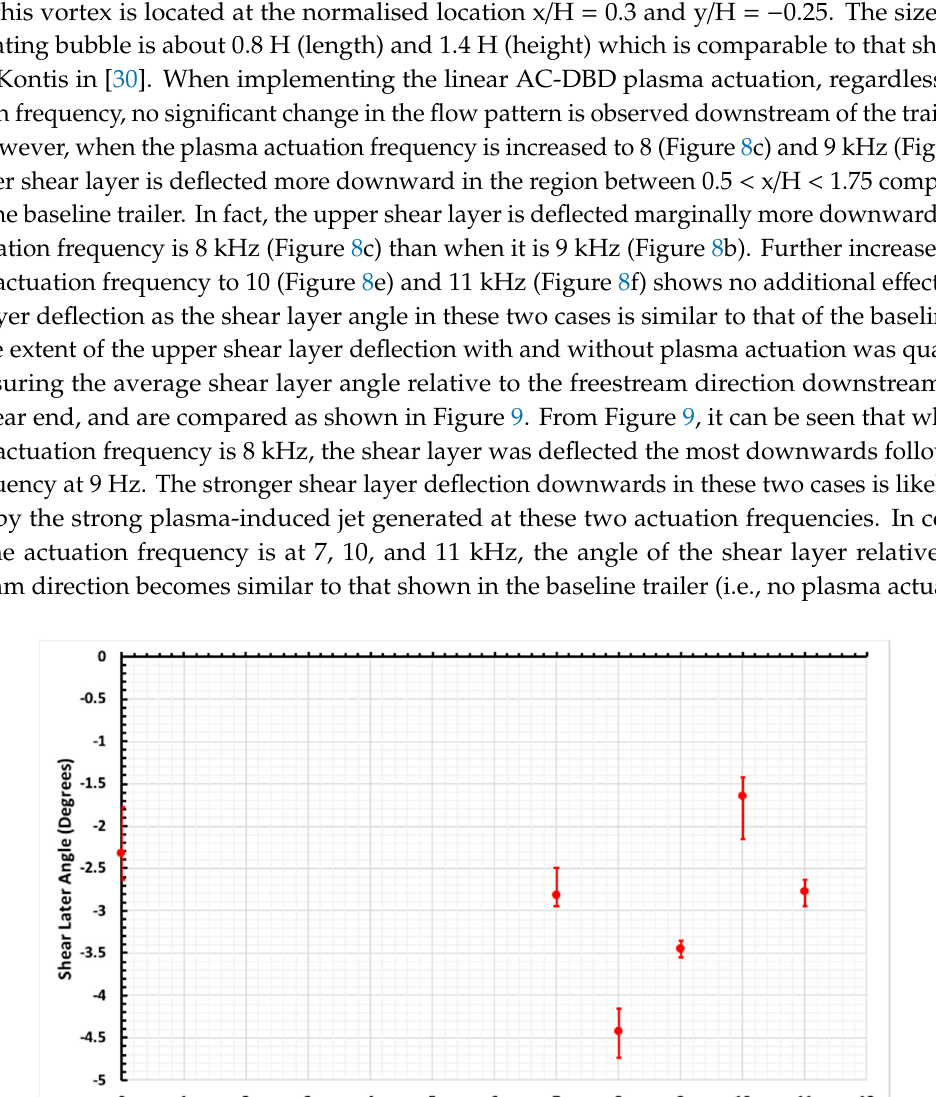
Figure 8. Streamtraces and normalised velocity magnitude contour downstream of the trailer rear end at various plasma actuation frequencies. ( a ) Baseline, ( b ) 7 kHz, ( c ) 8 kHz, ( d ) 9 kHz, ( e ) 10 kHz, and ( f ) 11 kHz.